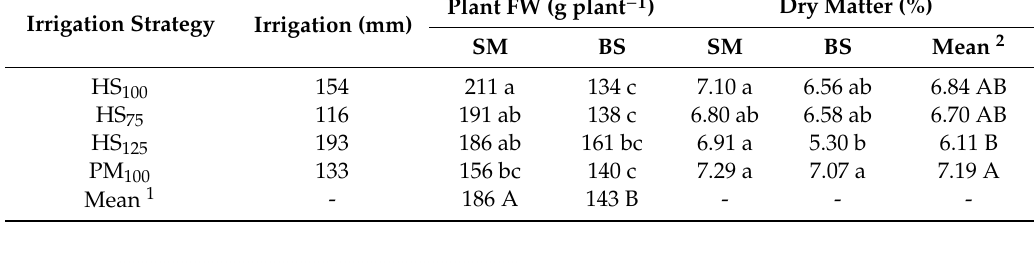
Table 7. Experiment 2: E ff ect of the interaction between irrigation strategy and soil mulching on the productive parameters of lettuce. Di ff erent letters indicate significant di ff erences in the Tukey HSD test ( p ≤ 0.05). Lower case letters indicate di ff erences between treatments; capital letters indicate di ff erences between the means of 1 soil mulching or 2 irrigation strategy factor. Data are the means of three replicates. HS 75 = recovery of 75% ET c calculated by the Hargraves–Samani equation; HS 100 = recovery of 100% ET c calculated by the Hargraves–Samani equation; HS 125 = recovery of 125% ET c calculated by the Hargraves–Samani equation; PM 100 = recovery 100% of ET c calculated by the Penman–Monteith equation. SM = Straw mulching; BS = Bare soil.